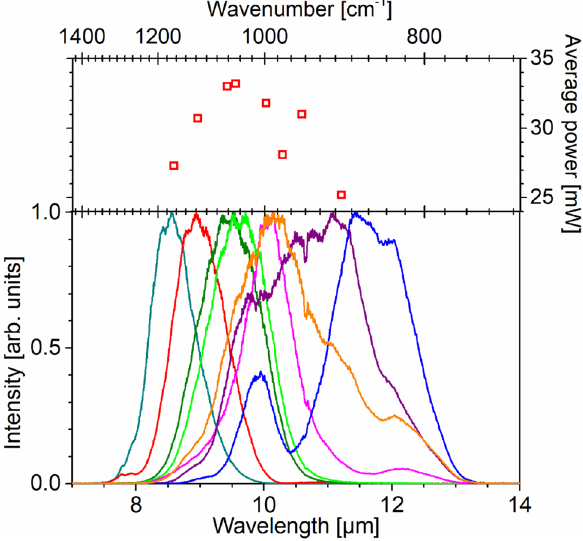
Figure 2. Top: Average power of the idler output beam as a function of center wavelength across the tuning range. Bottom: Representative idler spectra across the tuning